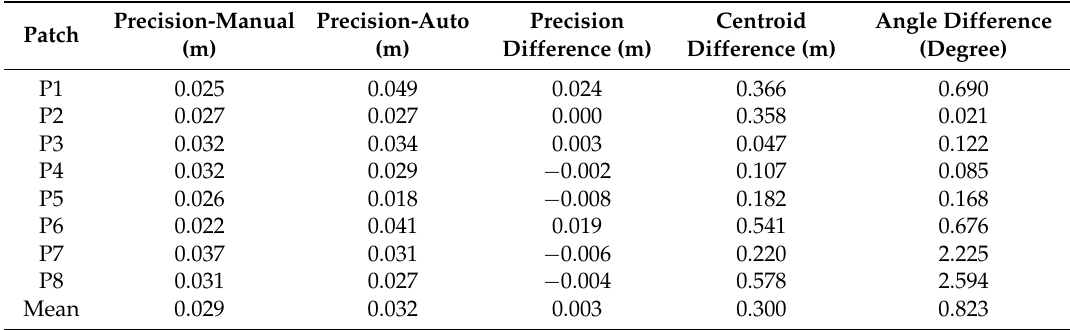
Table 10. Plane fitting precision, plane fitting precision difference, centroid difference, and angle difference values for building #1 (Spherical approach).